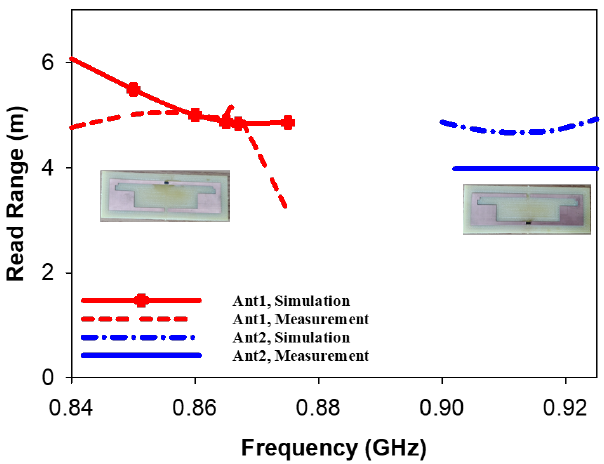
FIGURE 11: Measured and simulated read range for both configurations